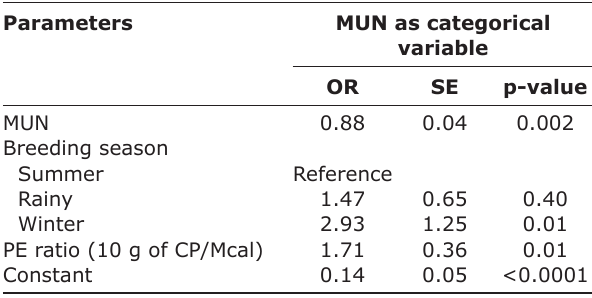
Table-2: Parameters associated with conception at first service from the final multivariable logistic regression among 295 cows on 43 smallholder dairy farms in Thailand in 2014-2015.